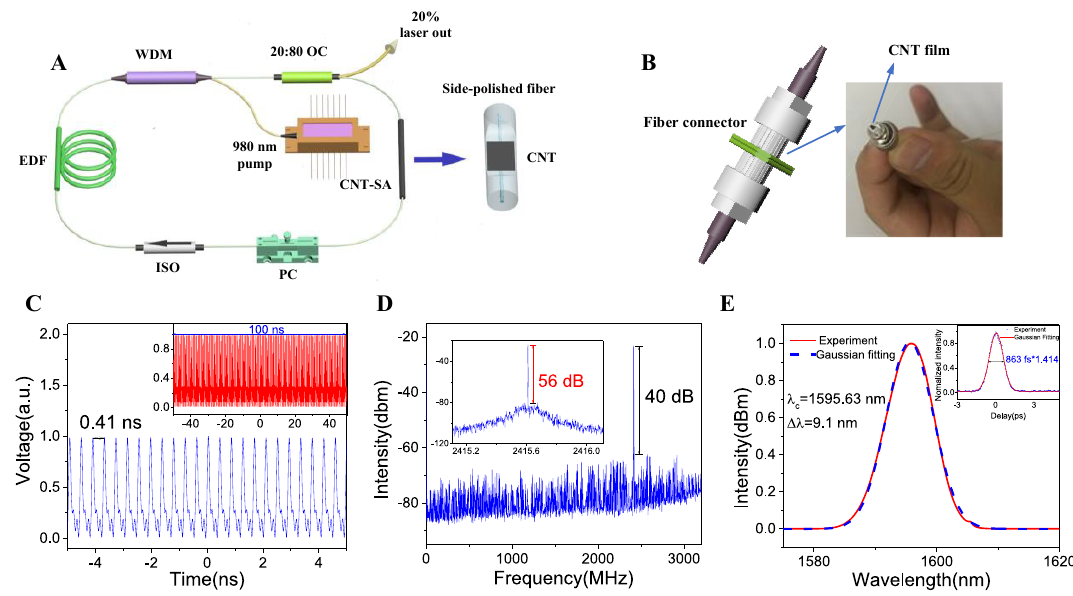
Figure 5: (A) PHML fiber laser with CNTs deposited on side-polished fiber. EDF, Er-doped fiber; ISO, isolator; PC, polarization controller; OC, output coupler. Jun et al. [194]. © Optical Society of America 2011. (B) Structure of a fi lm-type CNT SA. (C) The oscilloscope trace with a repetition rate of 2.415 GHz. Inset: the pulse train spanning 100 ns. (D) The RF spectra (span: 3.2 GHz, resolution: 10 kHz). Inset: RF spectra (span 1 MHz, resolution: 1 kHz). (E) The corresponding optical spectrum in linear scale. Inset: autocorrelation trace fi tted by Gaussian pro fi le. Huang et al. [204]. © IEEE